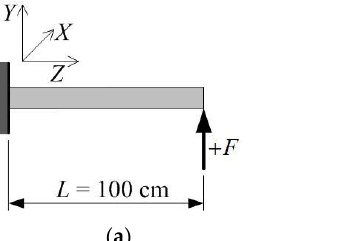
( b ) Figure 5. ( a ) Buckling load convergence for L = 50 cm and ( b ) buckling load vs. column length. As one can see, the shear locking does not occur in any of the shear deformable mod- els and the SD model’s results approach the shell solution. The results obtained by the SD1 model underestimate the column buckling strength in TF mode, leaving the construc- tion on the safe side if shear deformation effects are ignored. Since the beam model as- sumes a rigid cross-section and is unable to model the cross-section distortion, some dif- ferences between the beam model and the shell model are expected for higher loads and shorter beams where the cross-section distortion affects the critical load, as can be ob- served in the F mode results. Furthermore, the buckling strength reductions due to the shear deformability are 8% and 12% in comparison with the shear rigid model for the TF and F modes, respectively. The buckling strength increase due to the shear coupling ef- fects is 6% for the TF mode, and there is no influence of the shear couplings for the F mode. In Figure 5b, the variations in the value of buckling load against the column slenderness ratio are shown. It can be seen that the differences between the results obtained by the SR